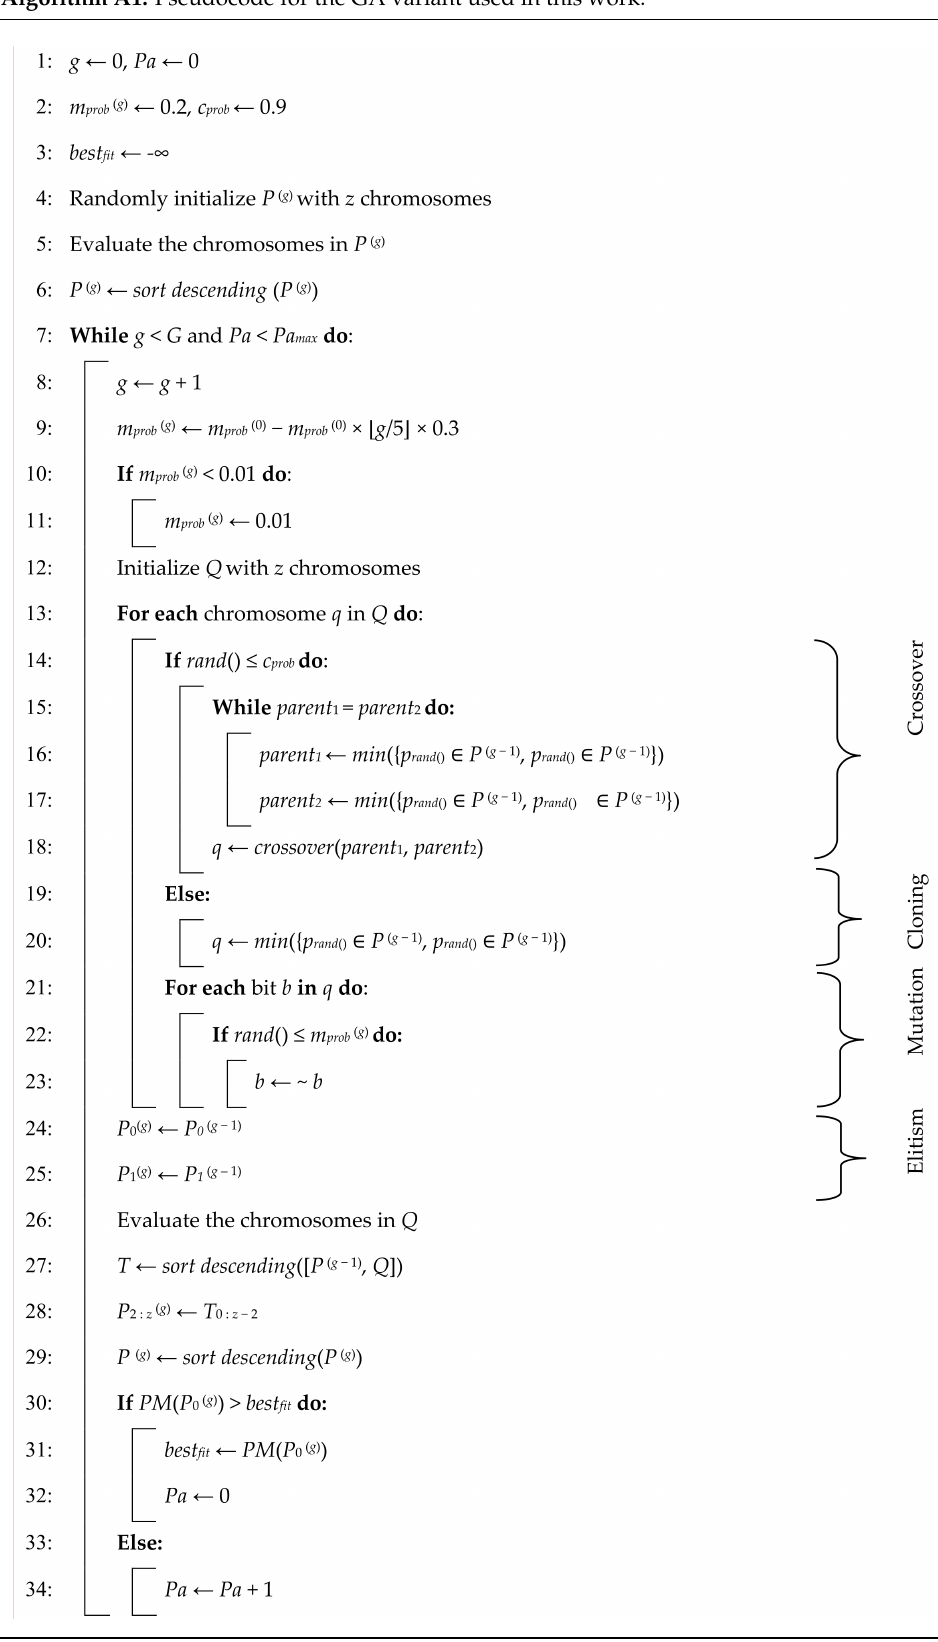
Algorithm A1. Pseudocode for the GA variant used in this